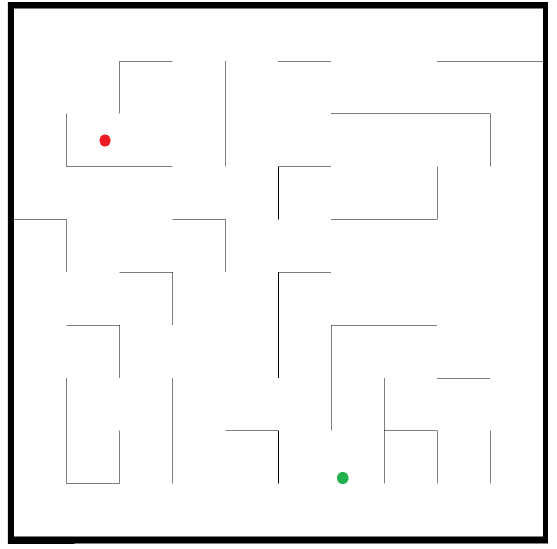
Figure 1. An exemplary operation environment of the mobile robot navigation